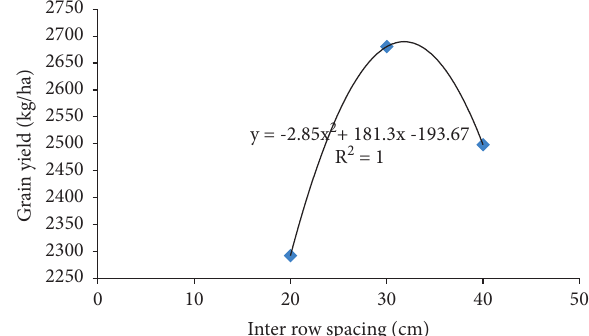
Figure 3: Relationship between inter-row spacing and grain yield of chickpea.